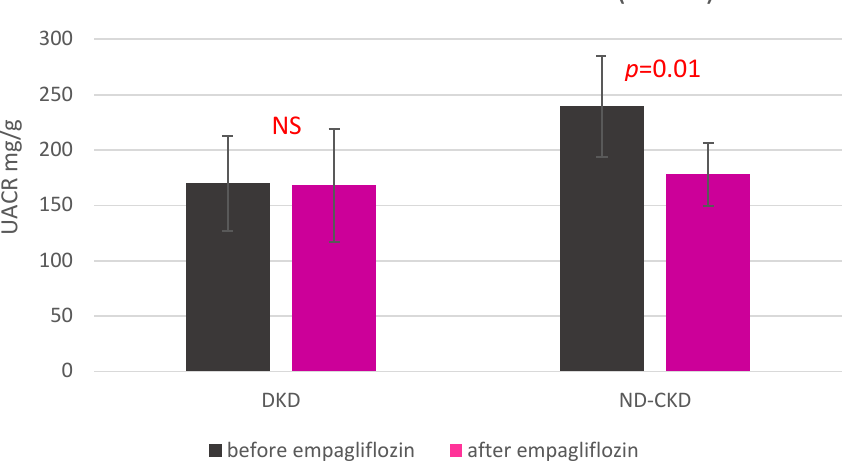
Figure 2. Urine albumin-to-creatinine ratio before and after the 7-day treatment with empagliflozin in diabetic and non-diabetic patients with chronic kidney disease. Abbreviations: UACR—urine albumin-to-creatinine ratio, DKD—diabetes kidney disease, non-DKD—non diabetes kidney disease.